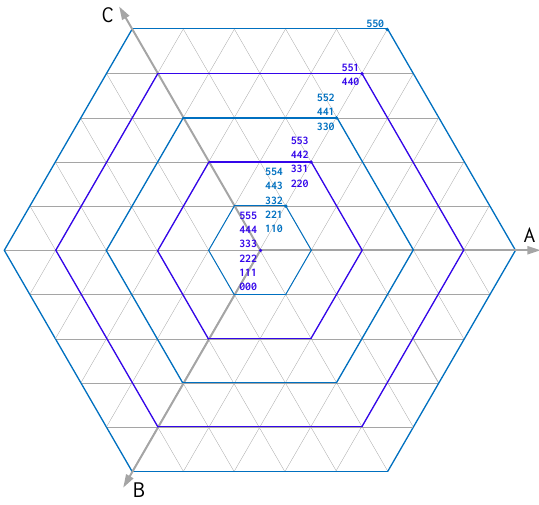
Figure 3. Space vector diagram for a six-level converter.